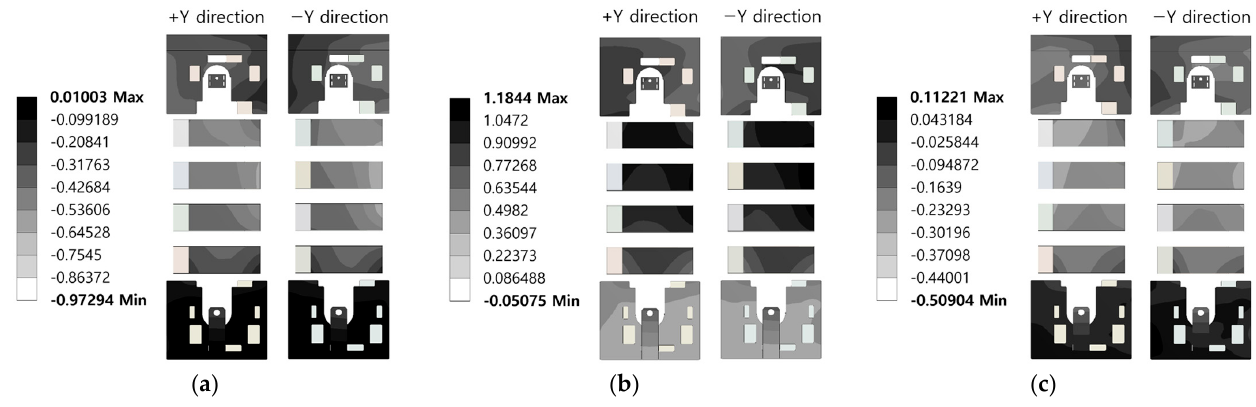
Figure 7. Mode Shapes: ( a ) 25th; ( b ) 26th; ( c ) 35th. Table 3. Mode Extraction.